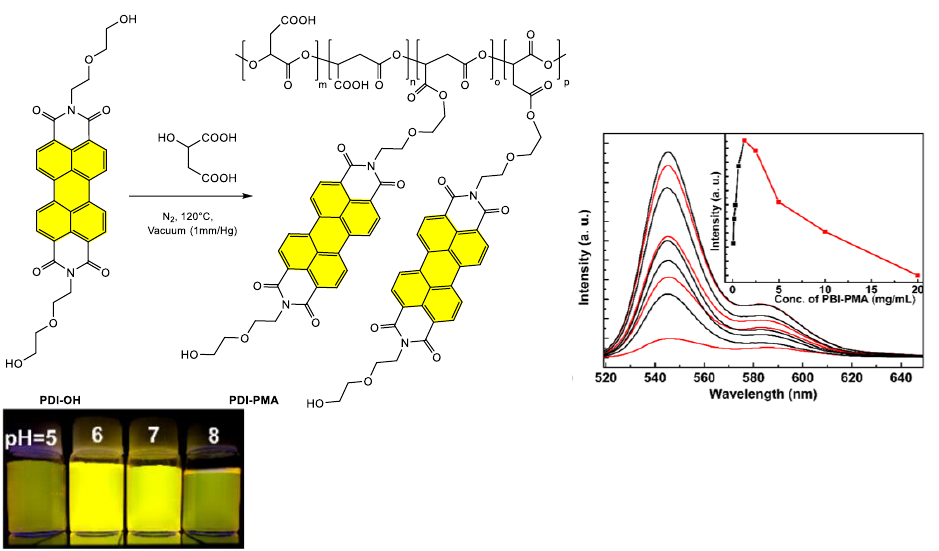
Figure 7. Synthesis of PDI-PMA polymer; fluorescence spectra of PDI-PMA in water; fluorescence spectra of the copolymer PDI-PMA in the buffers with various pH values (C = 1.25 mg·mL − 1 ) with λ exc = 488 nm. Reprinted with permission from reference